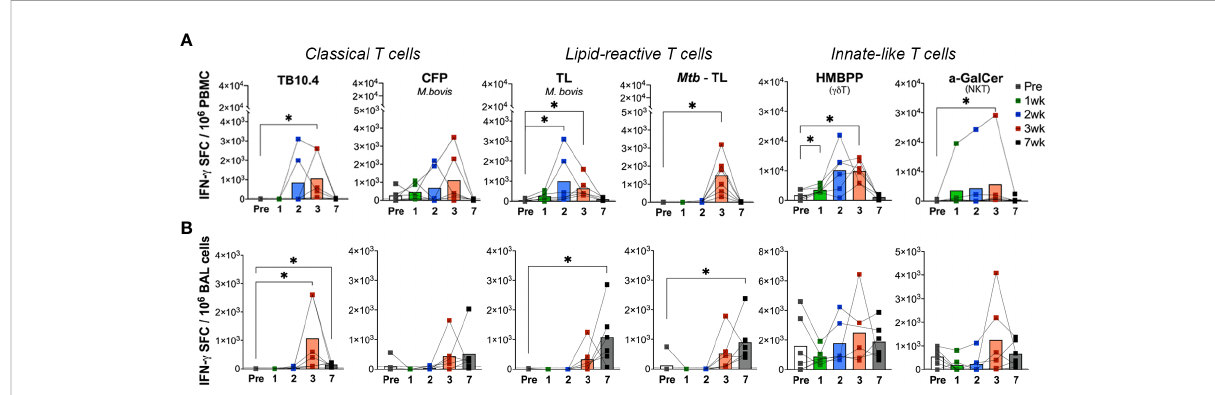
FIGURE 5 Kinetics of peptide- and lipid-reactive IFN- g responses in blood and BAL following aerosol BCG exposure. IFN- g responses expressed as SFU/ million cells, following stimulation with Mtb TB10.4 peptide pool, M.bovis culture fi ltrate proteins (CFP), M.bovis and Mtb TL fractions, E-4- hydroxy-3-methyl-but-2-enyl pyrophosphate (HMBPP), and alpha-galactosylceramide ( a -GalCer) in freshly isolated (A) PBMCs, and (B) BAL lymphocytes. Pre-BCG inoculation (white bars) and 1wk (green bars), 2wk (blue bars), 3wk post-BCG (red bars), and 7wk (grey bars) time-points were evaluated. Wilcoxon matched pairs signed rank test was used to compute difference between time points with respect to pre-BCG baseline. Asterisks indicate signi fi cant differences between time points (*p <